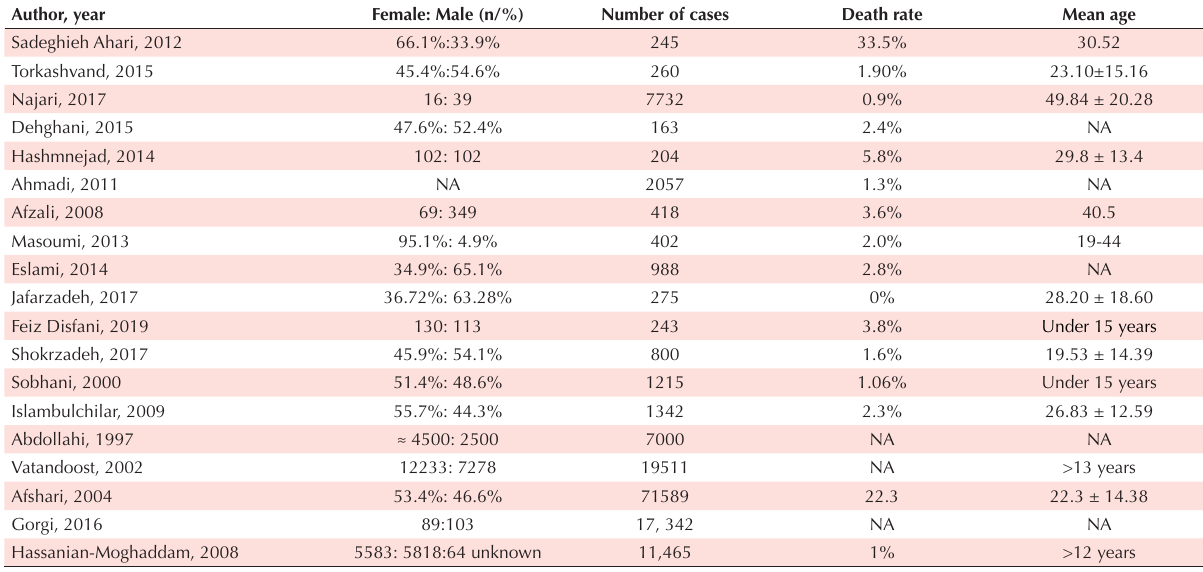
Table 1. Included studies in the meta-analysis Author,